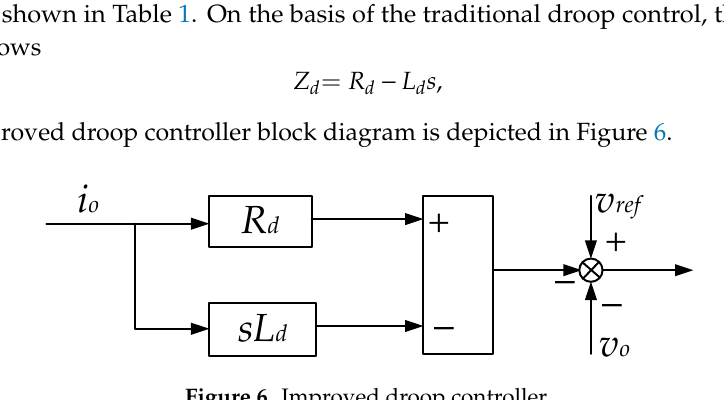
Figure 6. Improved droop controller.